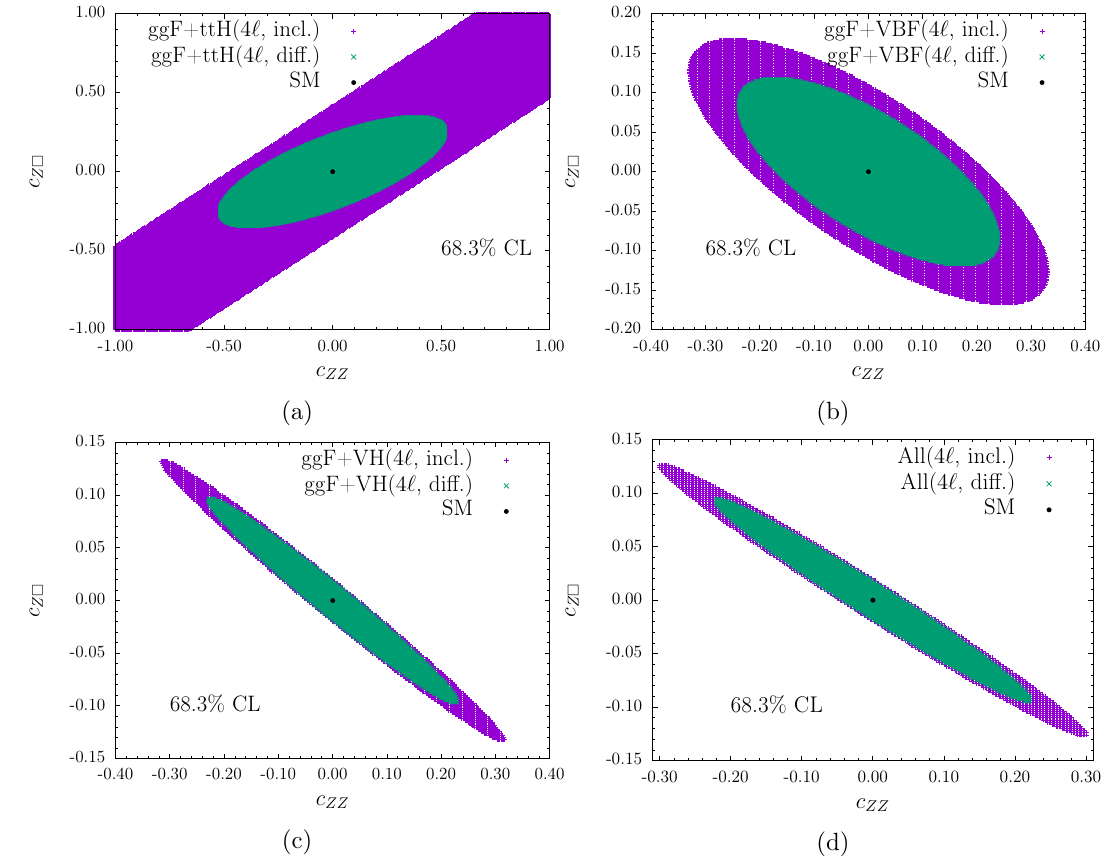
Figure 7. A comparison of global (cid:12)ts using inclusive (purple) and di(cid:11)erential (green) information in the de(cid:12)nitions of signal strength for the H 4 ‘ decay. Various cases based on the choice of ! production channels included in the (cid:12)t are displayed. By de(cid:12)nition, the best (cid:12)t for the parameters corresponds to the SM prediction i.e.